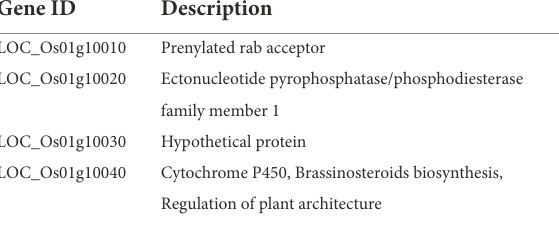
TABLE 1 List of candidate genes in the qLTG1